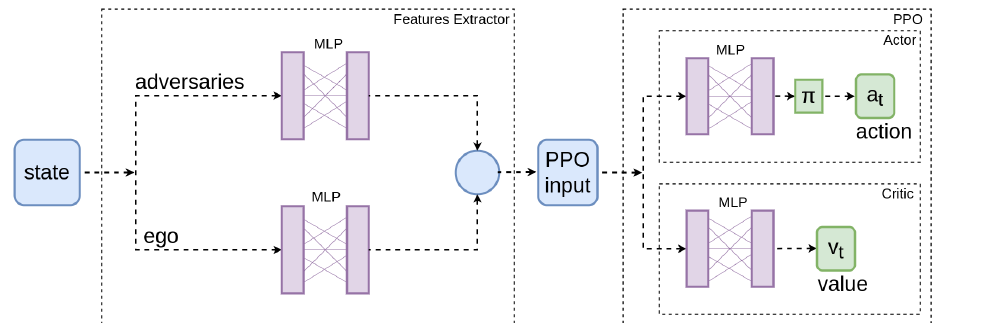
Figure 5. Neural network: After two fully connected layers, both adversaries and ego vehicle features are concatenated and fed the actor–critic structure with two layers of 128 neurons